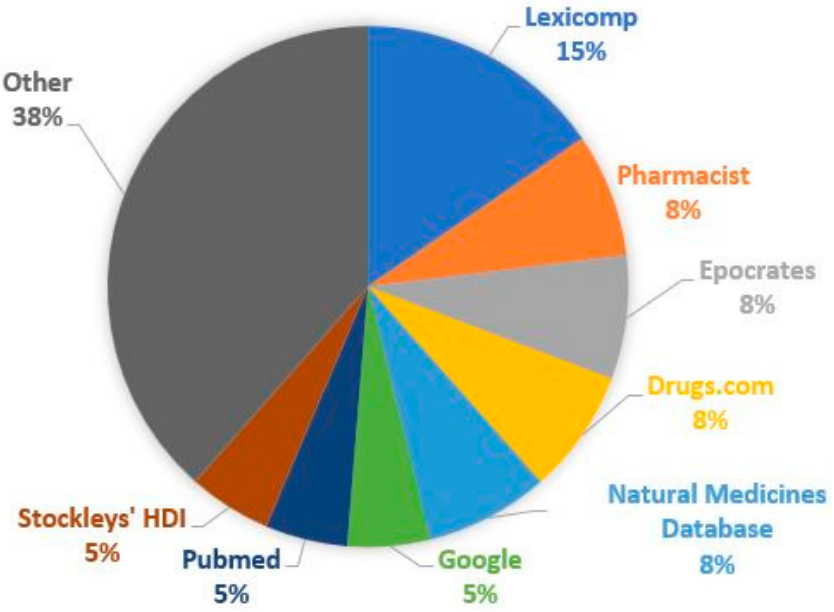
Figure 3. Common references used to evaluate HDI.